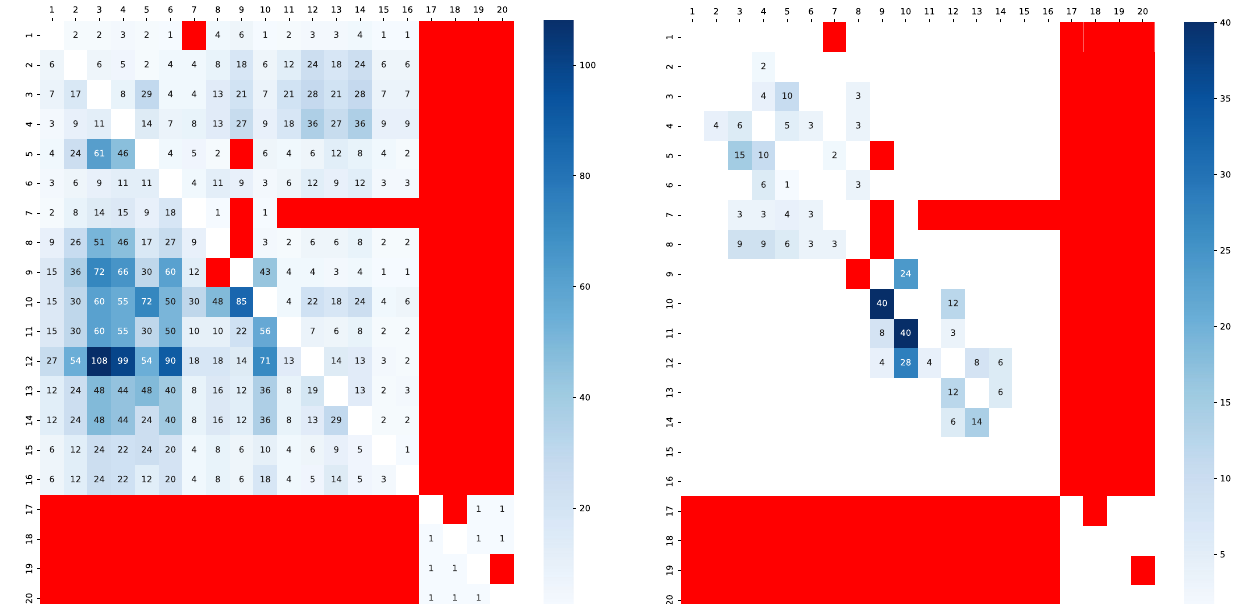
Figure 4. Heatmap for the combination number of (Left) k = 2 or (Right) 3 non-intersecting paths on a backbone communication network in Japan. The right color bar indicates the number of paths from zero (white) to the maximum (blue) by gradation. The case of no substitutive path is emphasized by red. The upper triangle represents the numbers for choosing the nearest neighbors as start s i and end t j points, while the lower triangle represents the numbers for choosing the next-nearest neighbors as start s i and end t j